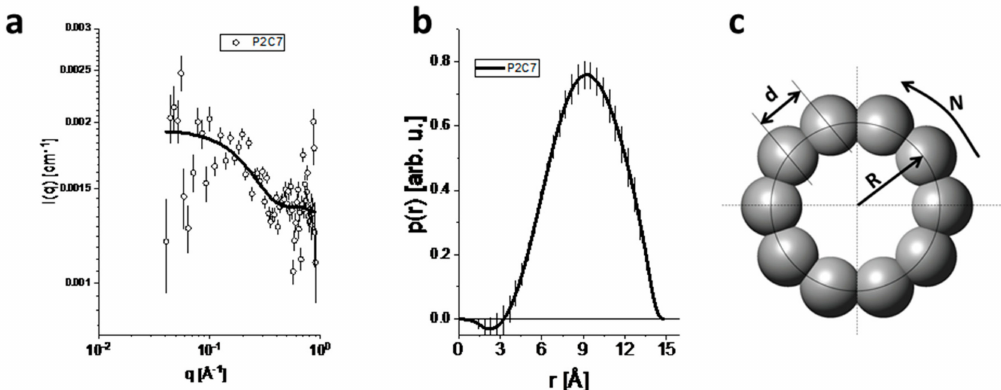
Figure 2. Experimental SAXS data for sample P2C7 and indirect Fourier transform (IFT) modeling. ( a ) SAXS data obtained at a distance of 38 cm between the sample and the detector (symbols) together with the IFT fit (solid line). ( b ) p(r) curve calculated by the IFT procedure. ( c ) Sketch of the circular